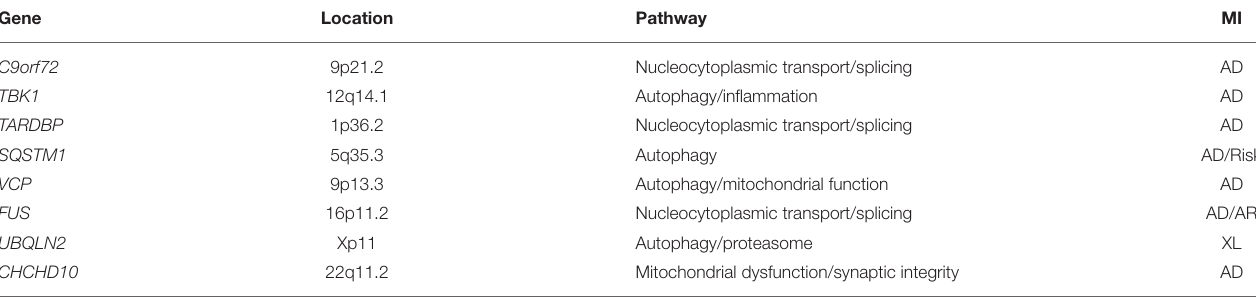
TABLE 1 | Genes in close association with both amyotrophic lateral sclerosis (ALS) and frontotemporal dementia (FTD) etiologies. Gene Location